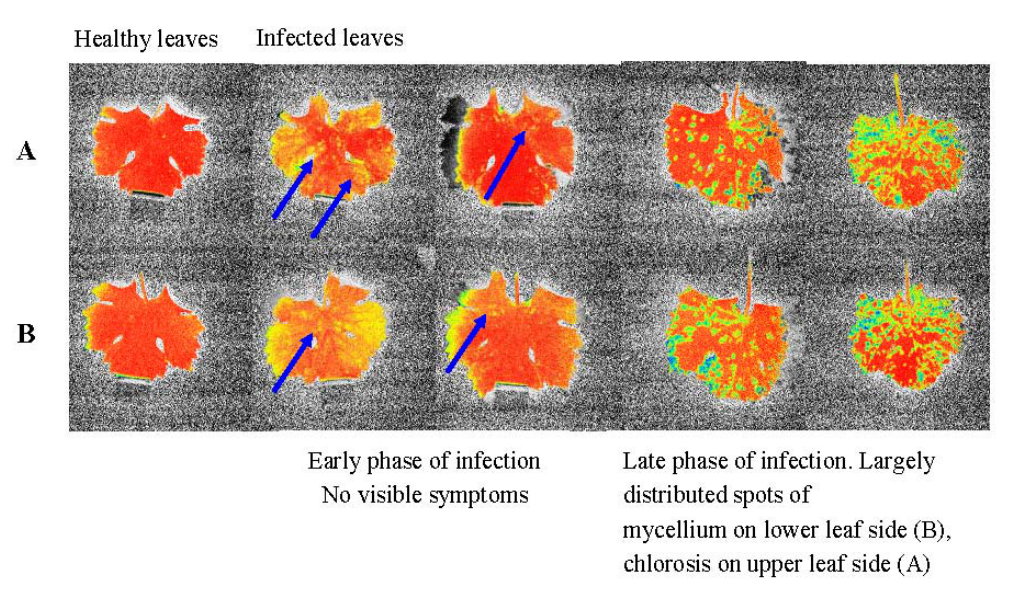
Figure 2. Infection by Plasmopara viticola progress in the leaves of susceptible variety Sauvignon. Upper row A illustrates increasing chlorosis on the upper side of the leaf, lower row B illustrates the growth of mycelium on the lower leaf side. The arrows highlight the spots where the infection (necrosis) started.